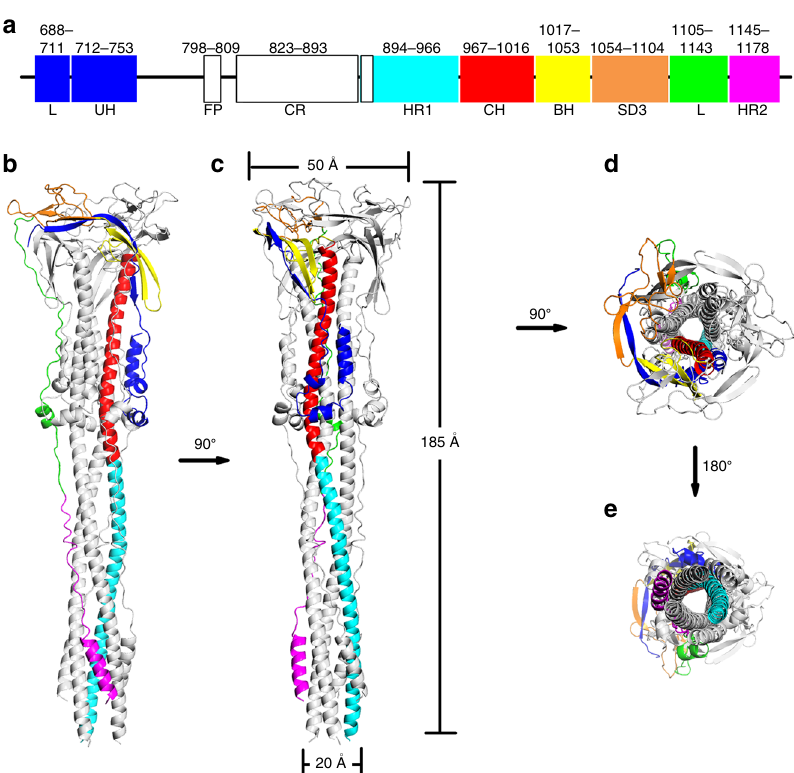
Fig. 1 Overall structure of SARS-CoV S2 fusion machinery in post-fusion state. a Schematic diagram of the SARS-CoV S2 subunit ectodomain. The uncolored region represents the undetermined region in our structure. L linker region, UH the upstream helices, FP fusion peptide, CR connecting region, HR heptad repeat, CH central helix, BH β -hairpin, SD3 subdomain 3. b – e Cartoon representation of the SARS-CoV S2 trimer in post-fusion state colored as shown in